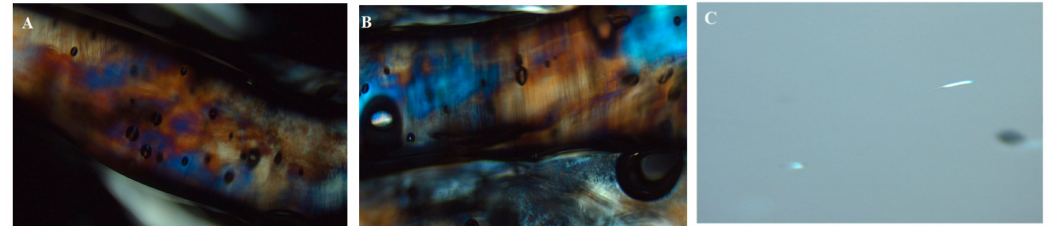
Figure 3. Photomicrographs of samples under polarized light microscopy ( A ) Lamellar liquid crystals of Tween 80/water, ( B ) Lamellar liquid crystals of Cremophor EL/water, ( C )